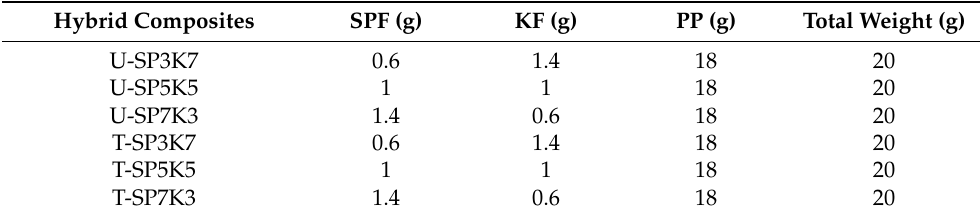
Table 1. Compositions of sugar palm fiber, kenaf fiber, and polypropylene hybrid composite (SPF/KF/PP).